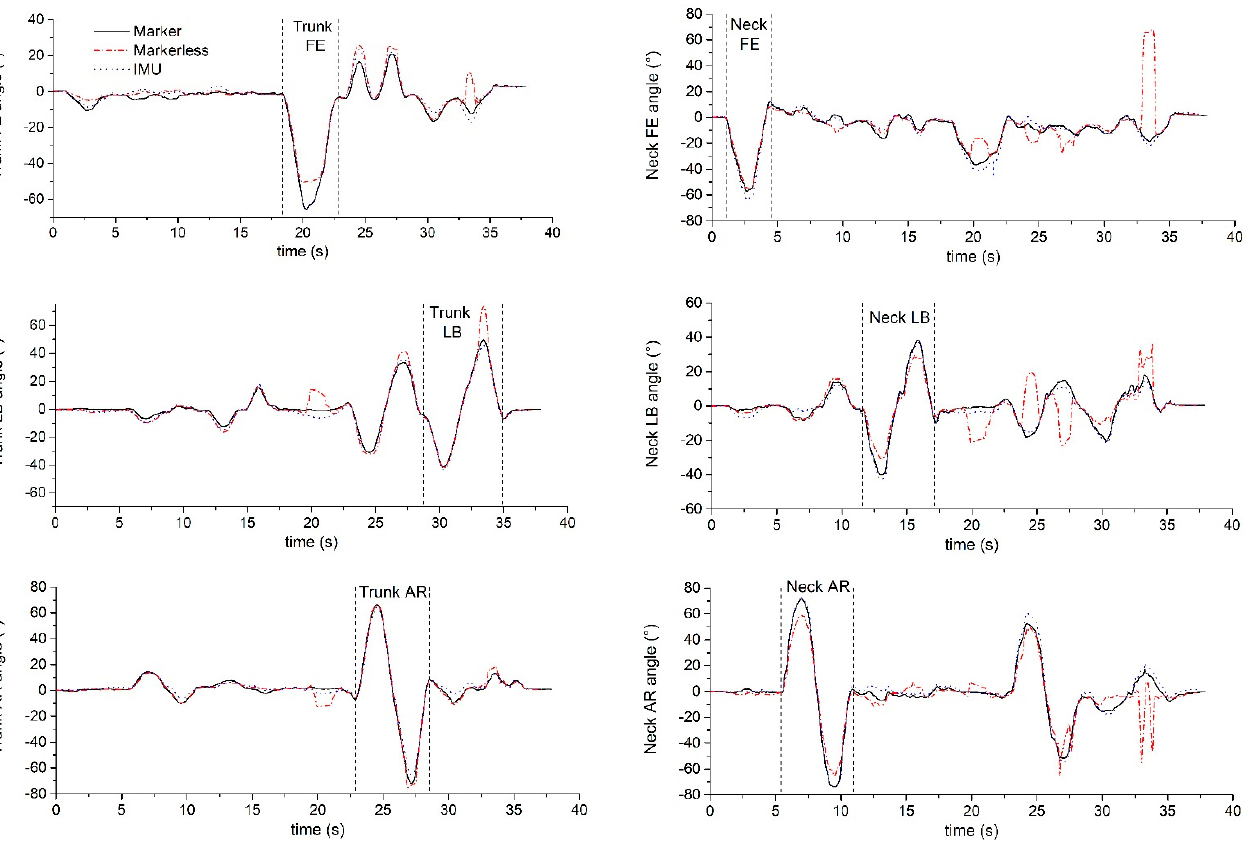
Figure 6. Exemplar simulated surgery task. 3.1. Accuracy and Validity for IMU-Based Neck and Trunk Kinematics The RMSE between the IMU-based method and the marker-based method were all below 3 degrees except for the trunk AR (4.7 degrees) and neck FE (3.7 degrees) when moving in a single plane (SP). During the simulated surgery task, the RMSE was less than 3.0 degrees for the trunk FE & LB, and less than 4.0 degrees for other neck and trunk angles. The ROM differences between the IMU-based method and the optoelectronic sys- tem were less than 3 degrees except for the trunk AR (5.0 degrees) and neck FE (5.4 de- grees) during SP-movements. The ROM differences between methods during the simu- lated surgery task were less than 3 degrees (shown in Figures 7 and 8 and Table 2). Limits of agreement (LOA) and mean relative ROM error for the IMU method during SP-move- ments and the simulated surgery task are shown in Table 2. There were systematic biases